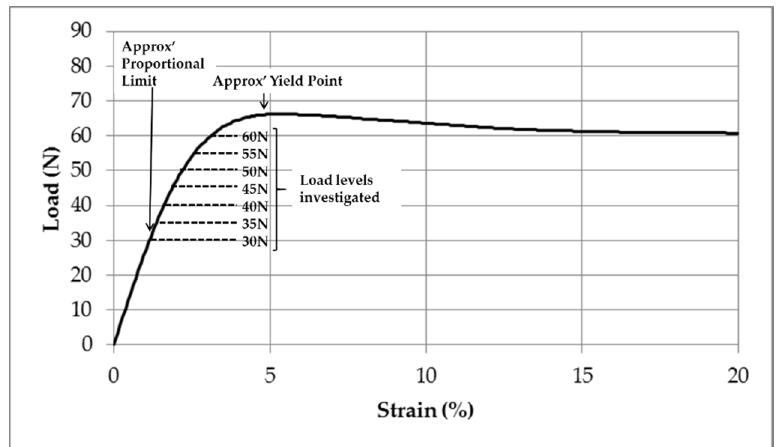
Figure 7. Identification of load levels for creep tests on a typical load/strain plot for a 1 mm PMMA fibre strained at 0.25 strain/min.